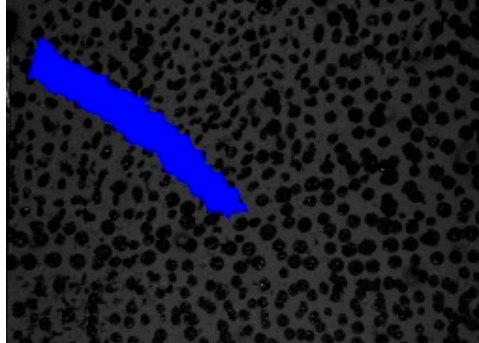
Figure 5. Connected components (in blue) of crack triangles.